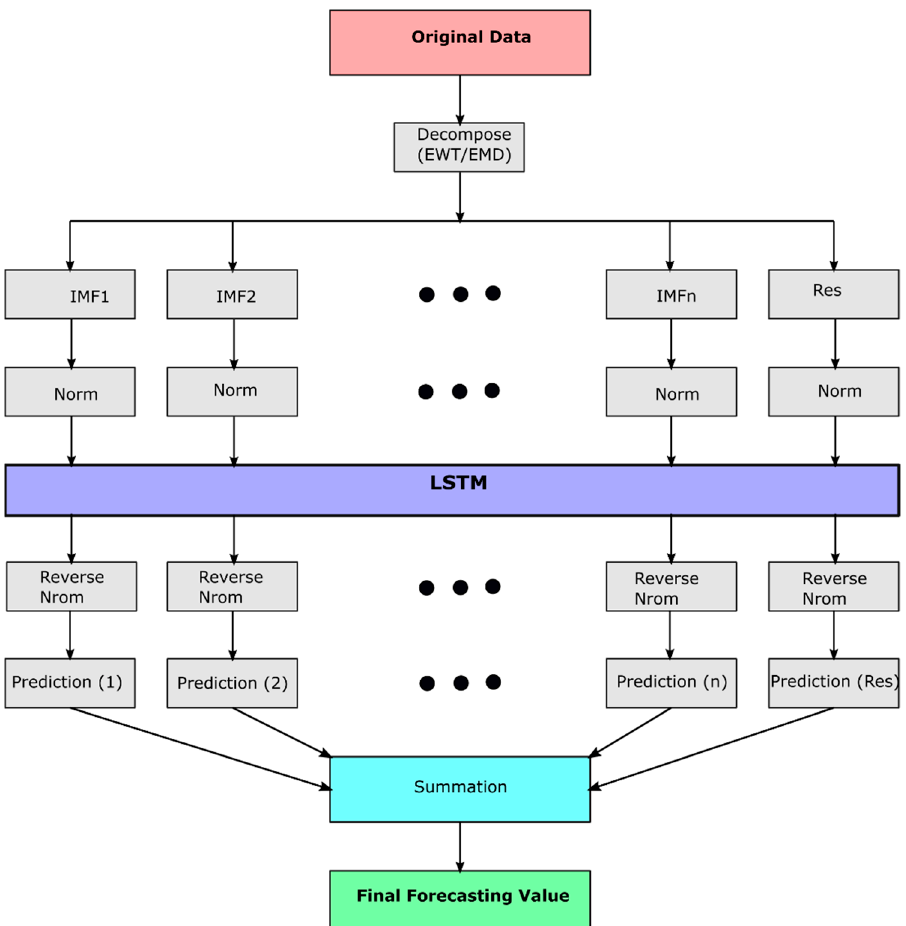
Figure 3. The architecture of the data driven LSTM hybrid model. IMF, intrinsic mode function; EWT, empirical wavelet transform; EMD, empirical mode decomposition.